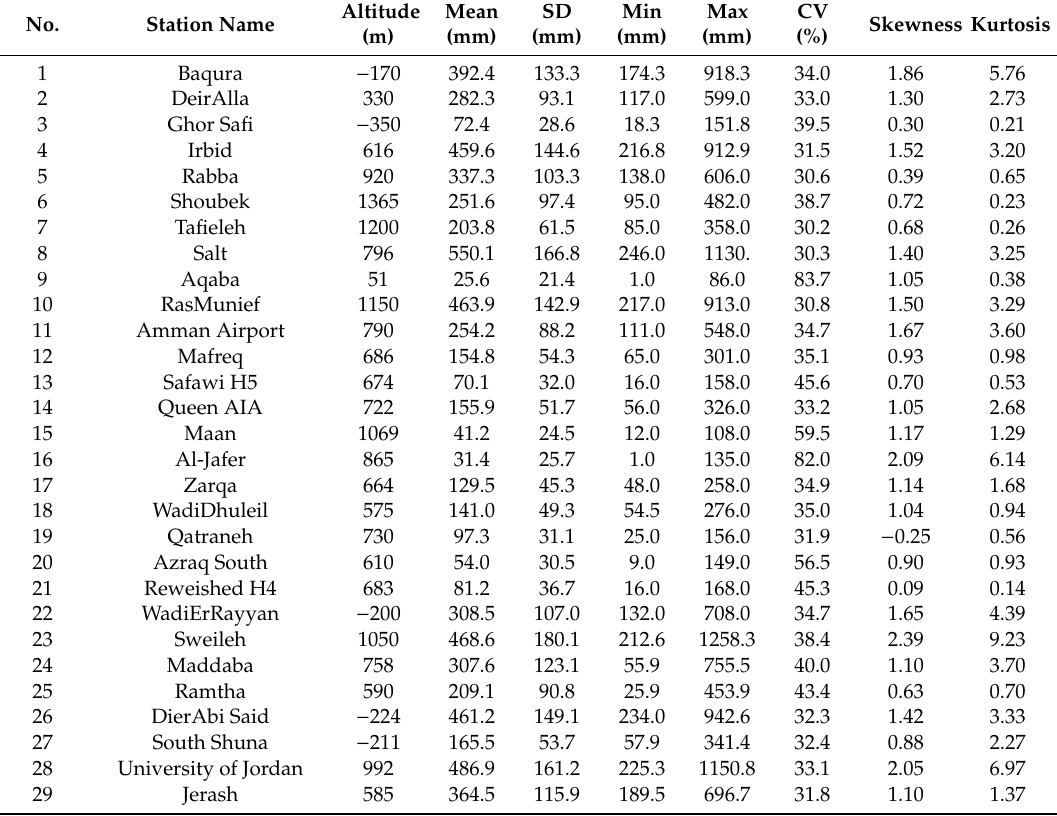
Table 1. Statistical summary for annual rainfall data per station. CV: Coe ffi cient of